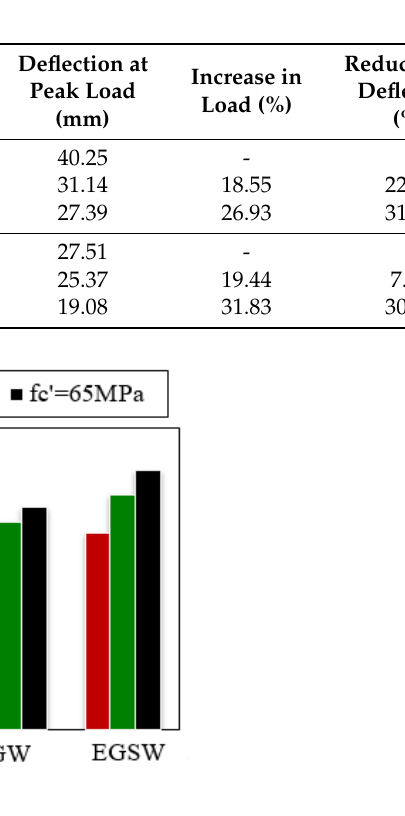
Figure 16. The variation of ultimate load as compressive strength changes.